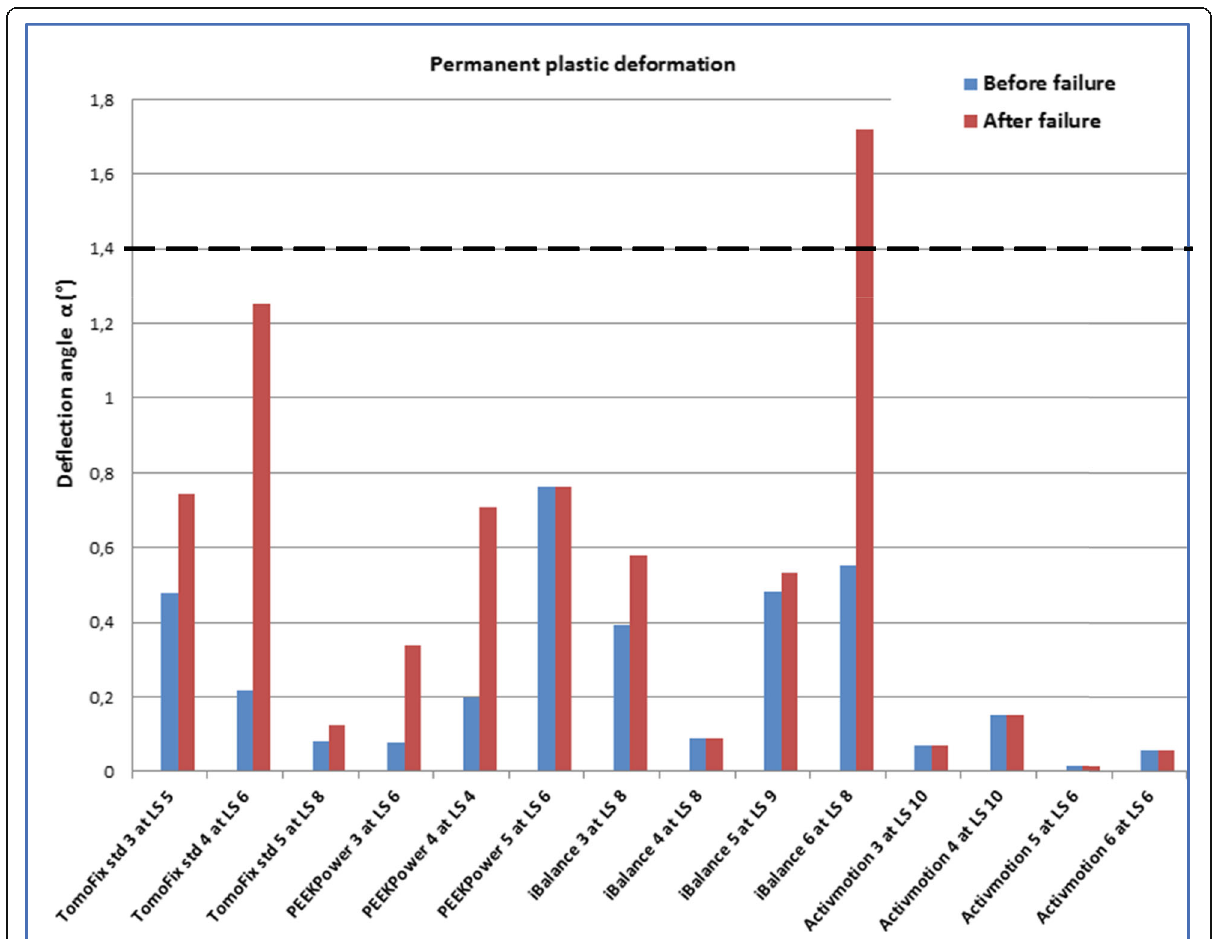
Fig. 6 Deflection angle or valgus-malrotation of the tibia head before and after the failure for groups I, II, III and VI. The failure type 1 was observed in the case of the specimen iBalance 6 after the collapse of the opposite cortex. LS “ n ” means the failure occurred at load step “ n ” . The values of the first 3 groups were retrieved from our previous studies. Same values were considered before and after the failure for the Activmotion